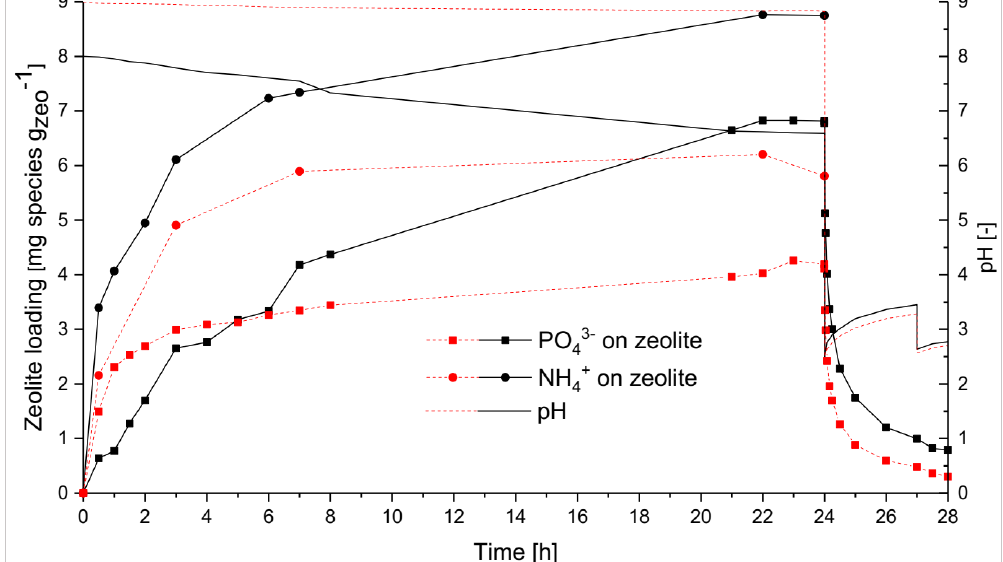
Figure 5. Effect of initial pH value at higher phosphate concentration. Initial values of experiments—black solid lines: 267 mg NH 4+ L − 1 . 245 mg PO 43 − L − 1 pH = 8.00, removal rates: P = 56%, N = 66%; red dashed lines: 263 mg NH 4+ L − 1 . 246 mg PO 43 − L − 1 pH = 9.00, removal rates: P = 34%, N =